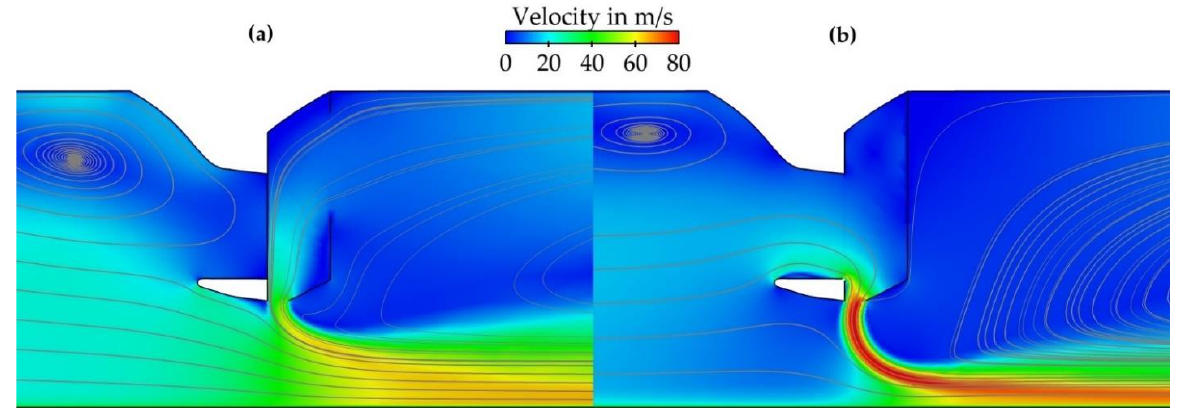
Figure 30. Velocity distribution at front nozzles of the fan-generating device for inlet speed of 40 m/s. ( a ) Air curtain fan active; ( b ) Support fan active.